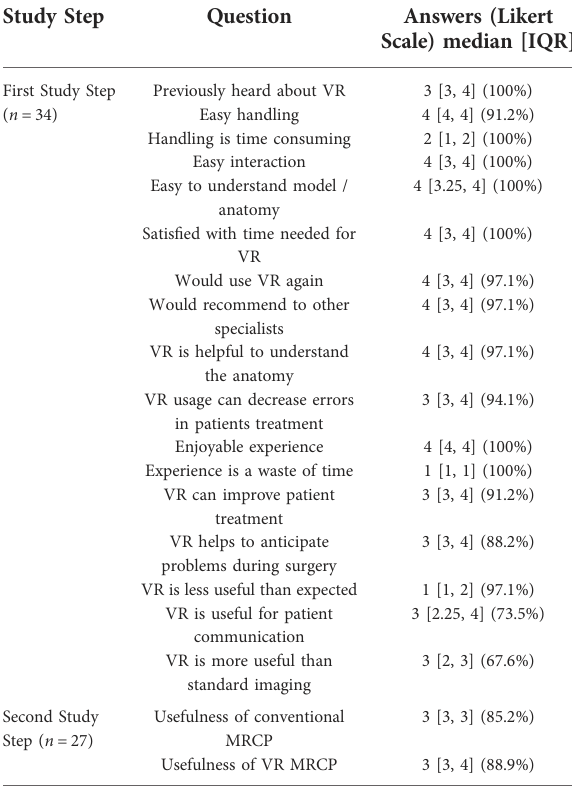
TABLE 3 Results of the questionnaire after the fi rst study step ( n =34) and the second study step ( n =27), respectively. Study Step Question Answers